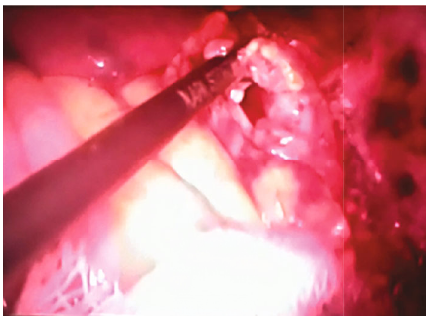
Figure 2: Photo from the surgical monitor depicting an infected hydatid cyst in the left kidney managed laparoscopically.